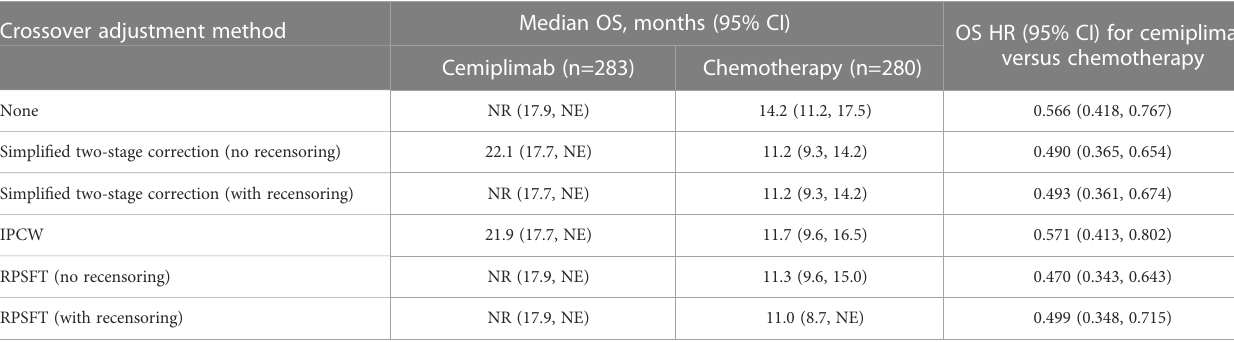
TABLE 2 Crossover adjustment results among the EMPOWER-Lung 1 PD-L1 ≥ 50% population.